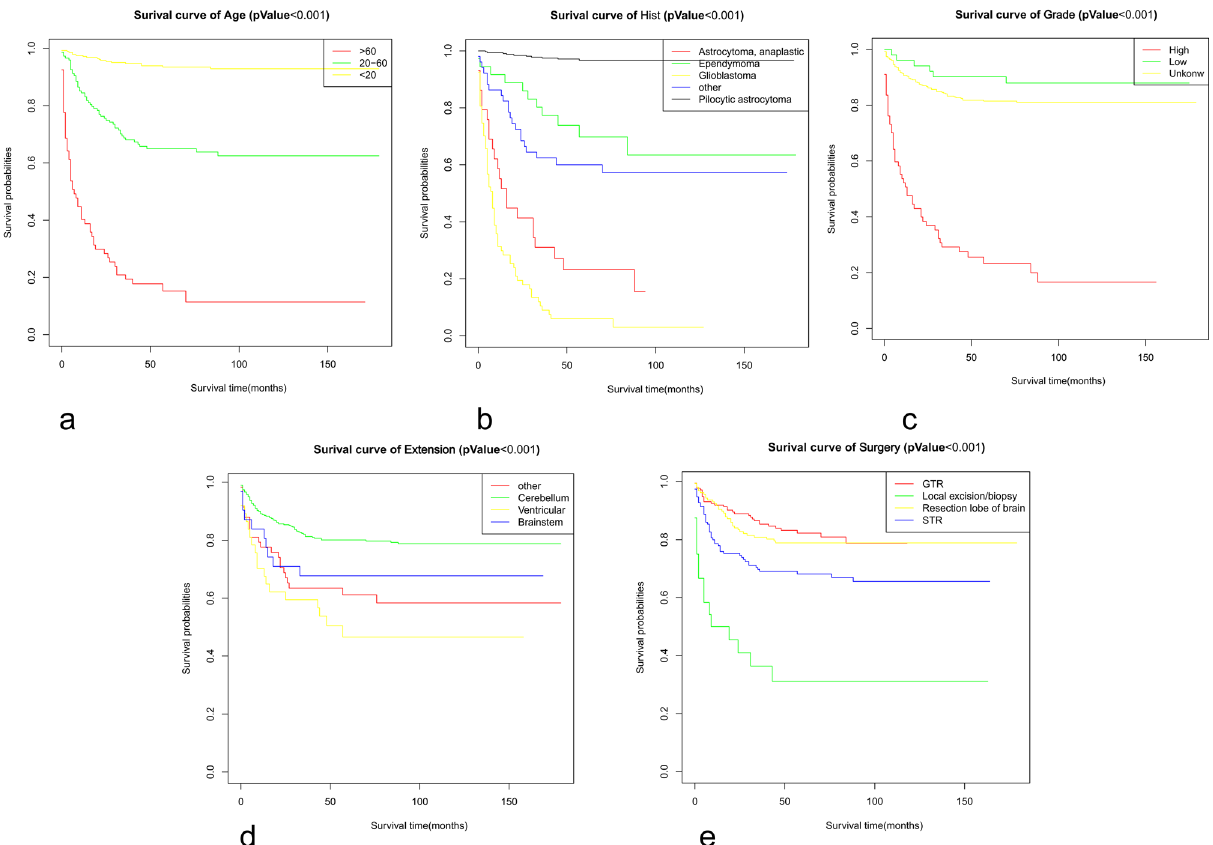
Figure 2. Kaplan–Meier curves for patients with cerebellum glioma by different variates. ( a ) Age, ( b ) Histology, ( c ) WHO Grade, ( d ) Extension, ( e )